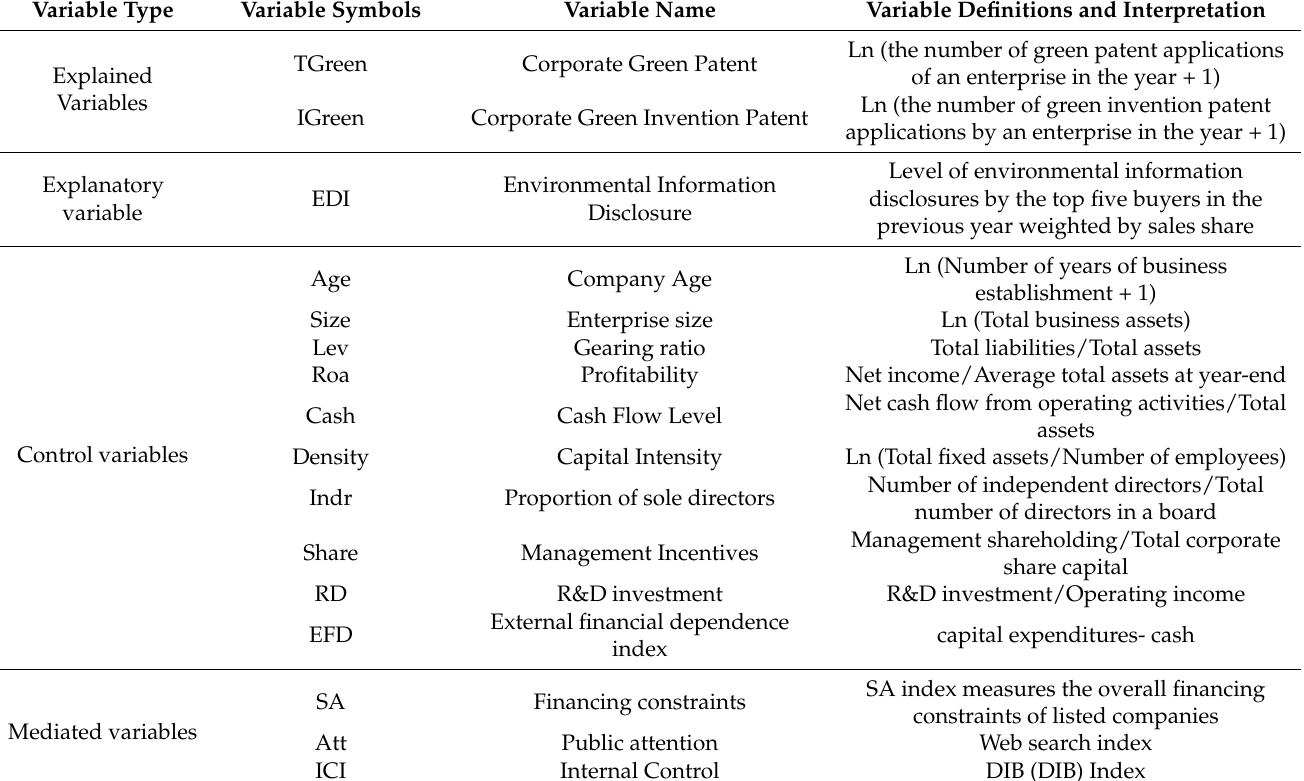
Table 1. Definitions of